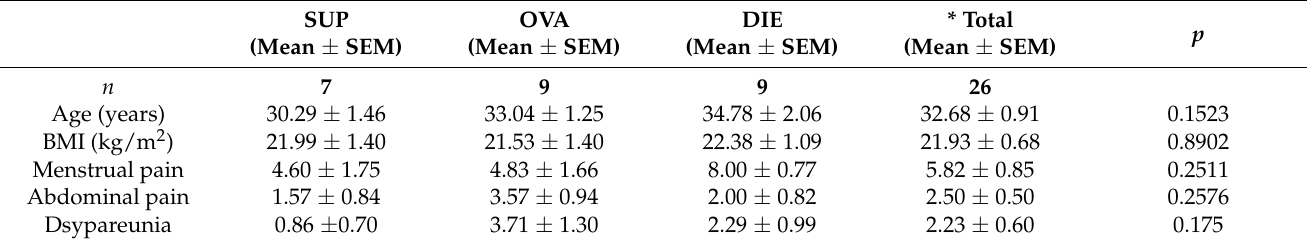
Table 1. Clinical parameter of patients included in this study.